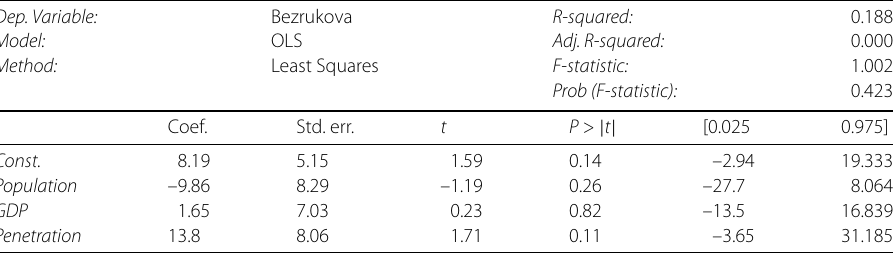
Table 6 OLS Regression results for correlation between Facebook penetration, GDP and population of each region and the faultline strength (Bezrukova) Dep.Variable: